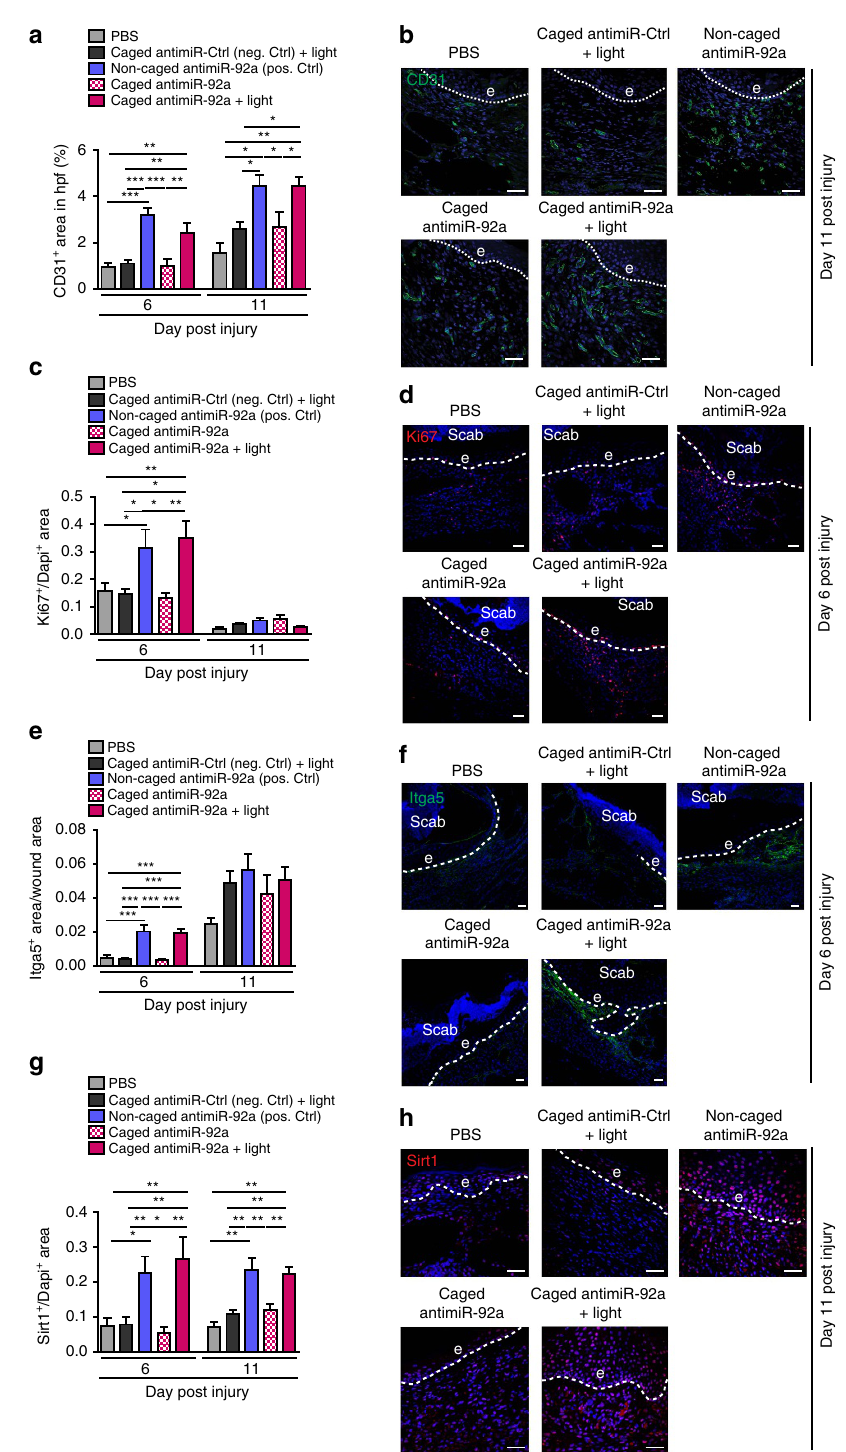
Figure 3 | Inducible miR-92a inhibition increases angiogenesis and proliferation. ( a ) Immunohistochemical quantification of the CD31-positive-stained area within the granulation tissue and ( b ) representative images of wound sections 11 days post injury stained for CD31. Different groups as indicated. n ¼ 4–14 wounds per group on 3–7 different mice. Hpf, high power field. ( c ) Morphometric quantification of the Ki67 þ area normalized to the Dapi þ area within the granulation tissue 6 and 11 days post injury. ( d ) Ki67 and Hoechst double staining of day 6 wounds. n ¼ 3–10 wounds per group on 2–5 different mice. ( e ) Morphometric quantification of the Itga5 þ area normalized to the wound area at day 6 and 11 post injury. ( f ) Itga5 and Dapi double staining of day 6 wounds. ( g ) Morphometric quantification of the Sirt1 þ area normalized to the Dapi þ area within the granulation tissue 6 and 11 days post injury. ( h ) Sirt1 and Hoechst double staining of day 11 wounds. Scale bars, 50 m m; e, hyperproliferative epithelium. Data are expressed as means ± s.e.m. Significance of difference was analysed using analysis of variance one-way test analysis with Newman–Keuls Multiple Comparison Test. *** P o 0.001, ** P o 0.01, * P o 0.05.